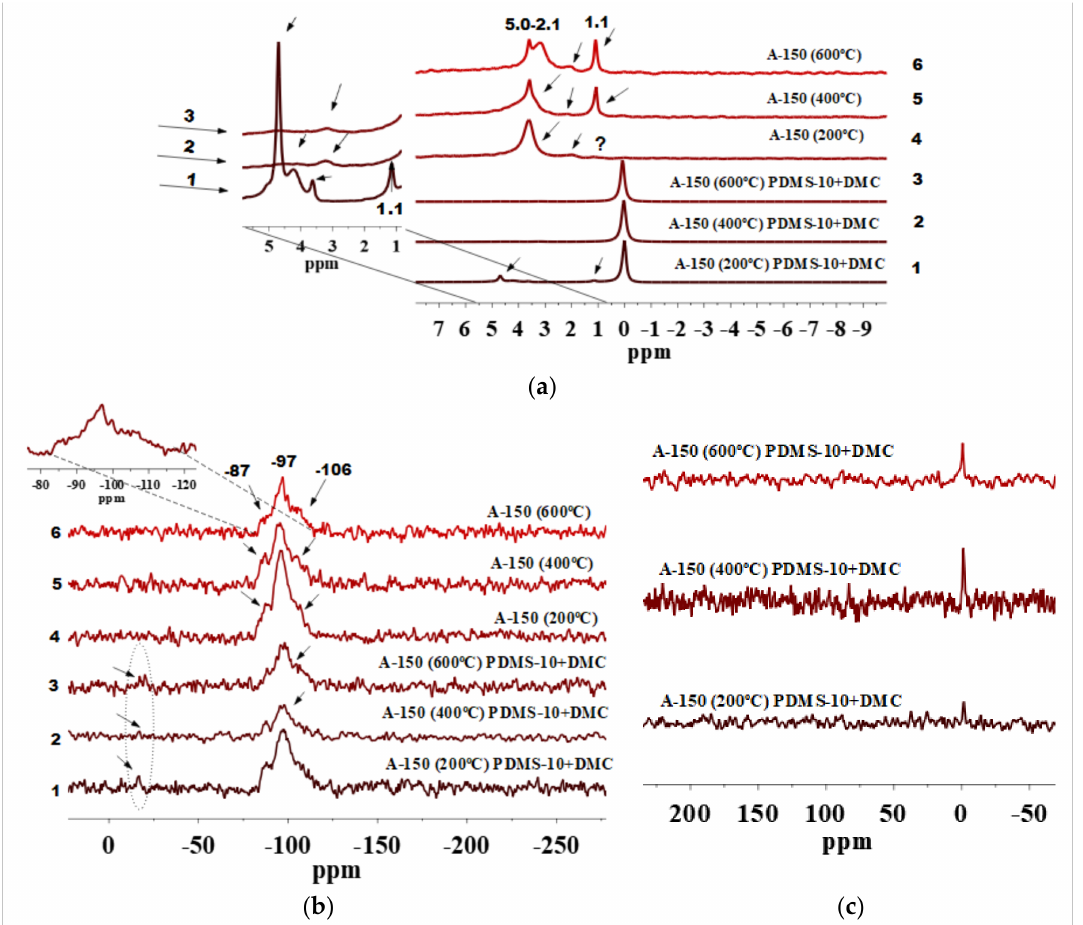
Figure 2. ( a ) 1 H MAS NMR, ( b ) 29 Si CP/MAS NMR and ( c ) 13 C CP/MAS NMR spectra of fumed silica A-150 preheated at 200, 400 and 600 ◦ C and modified by